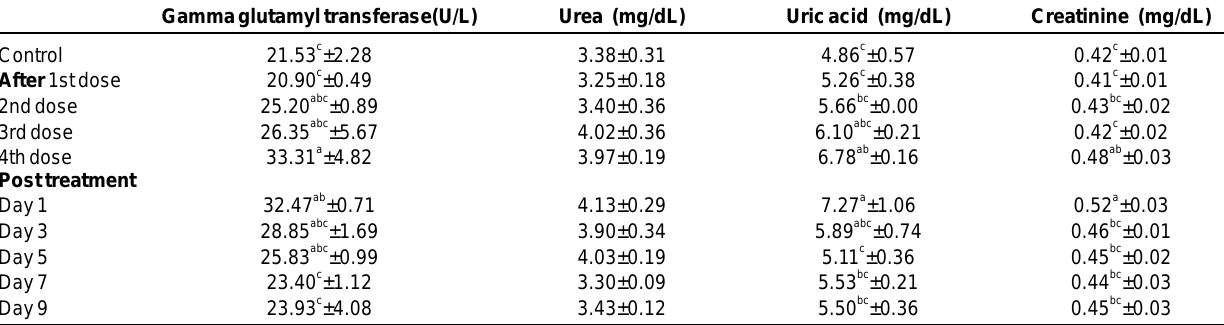
Table-2. Effect of enrofloxacin administration (10mg/kg body weight, in drinking water for 5 successive days) on gamma glutamyl transferase, urea, uric acid and creatinine levels (data is shown as Mean±SE,